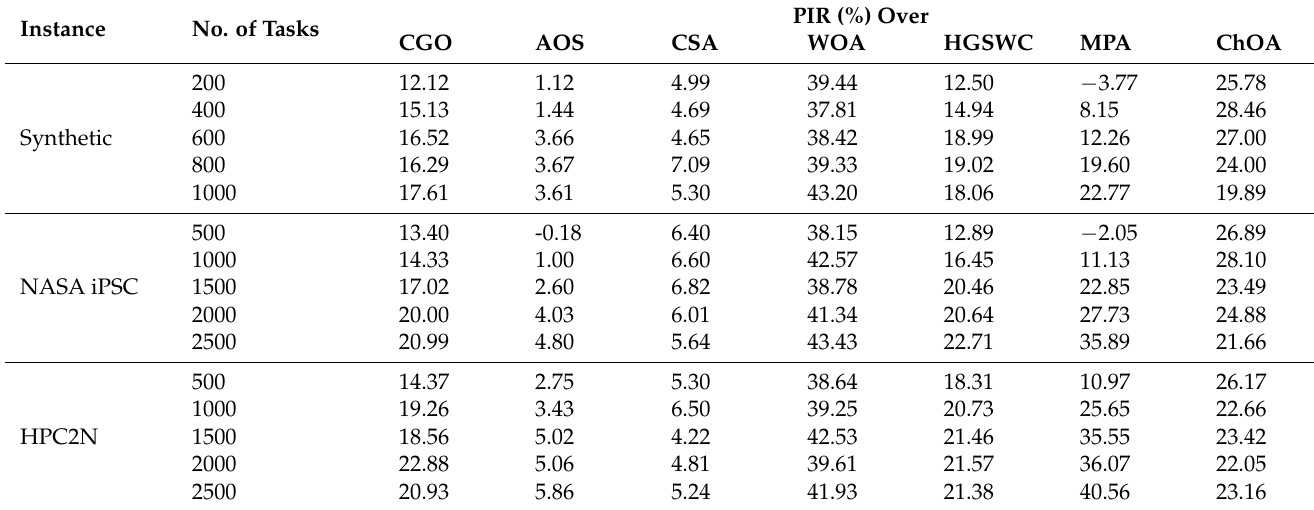
Table 6. The PIR ( % ) of the average makespan for different workload